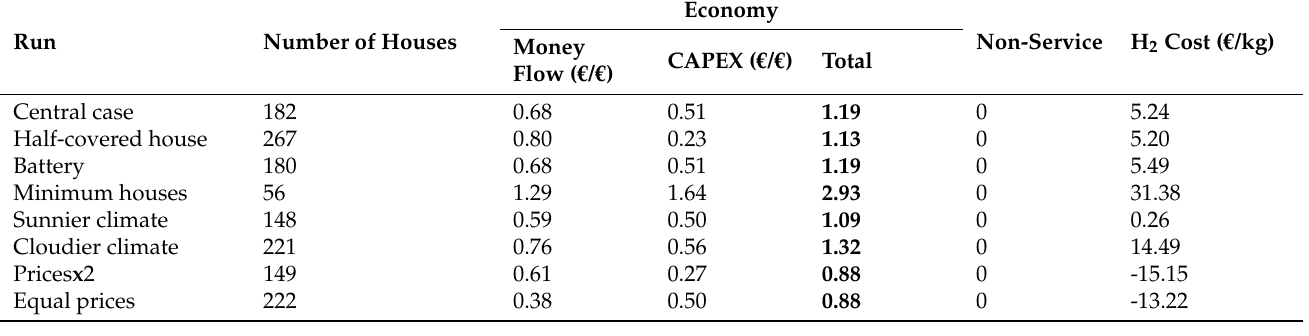
Table 7. Final performance in case 2.